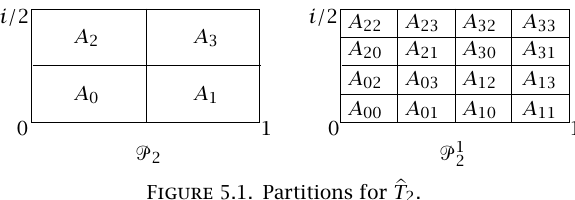
Figure 5.1 . Partitions for (cid:13) T 2